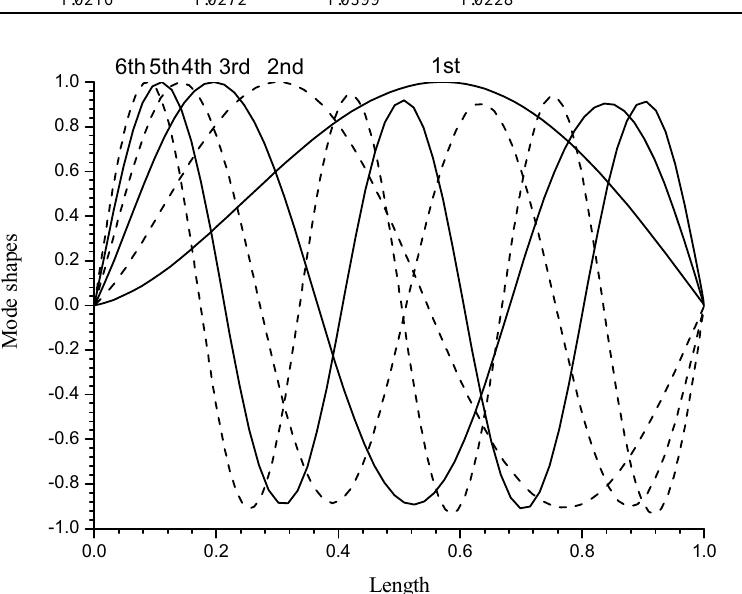
Fig. 3. First six nonlinear mode shapes of a beam with the left end clamped and the right end simply supported ( L/r = 20 , a/r = 0 . 3